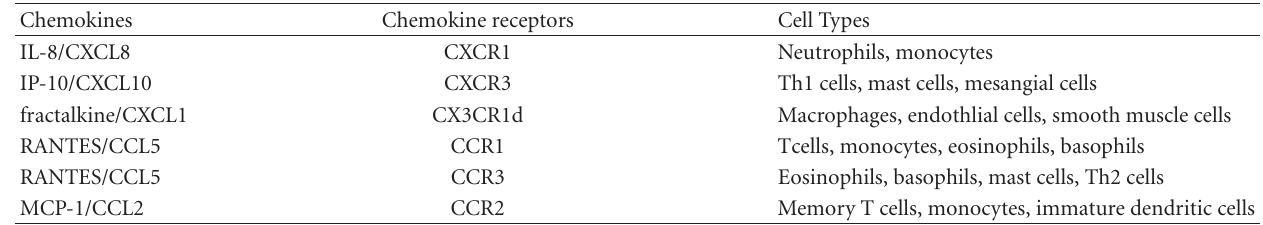
Table 2: Chemokines and chemokine receptors in